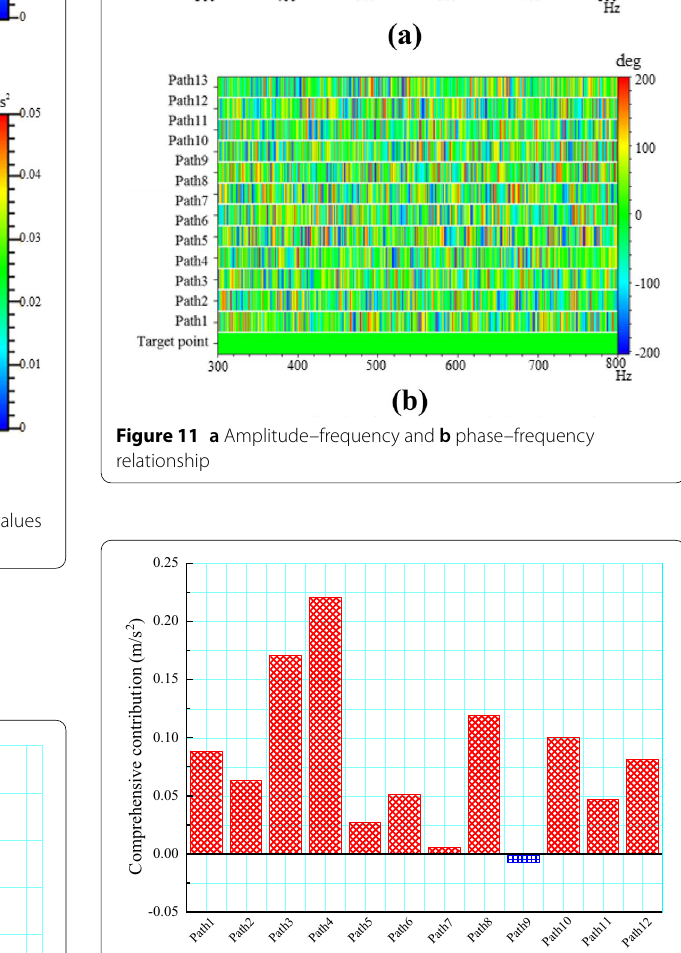
Figure 12 Contribution of secondary transfer paths over the range of 300–800